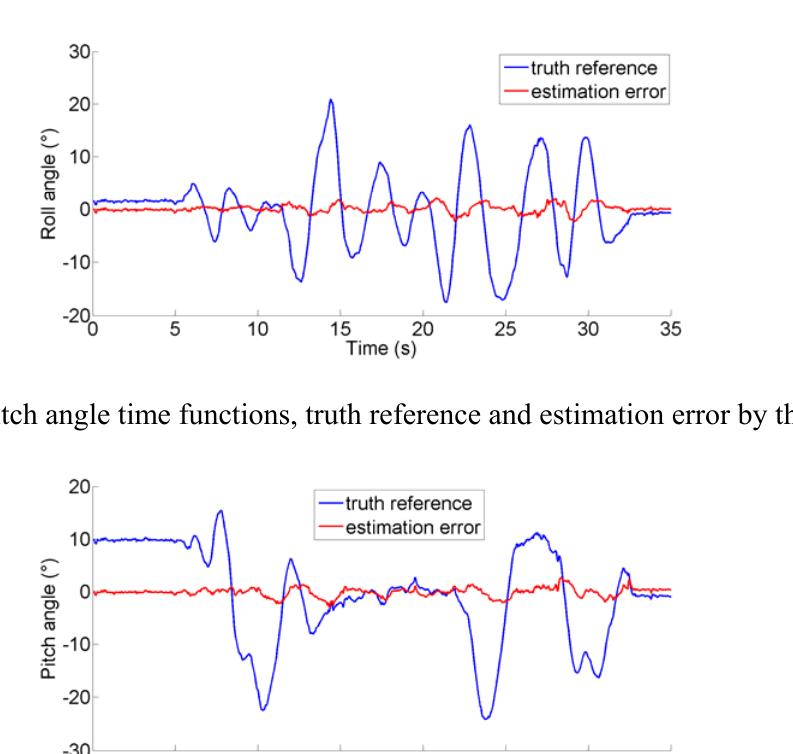
Figure 7. Roll angle time functions, truth reference and estimation error by the EKF.